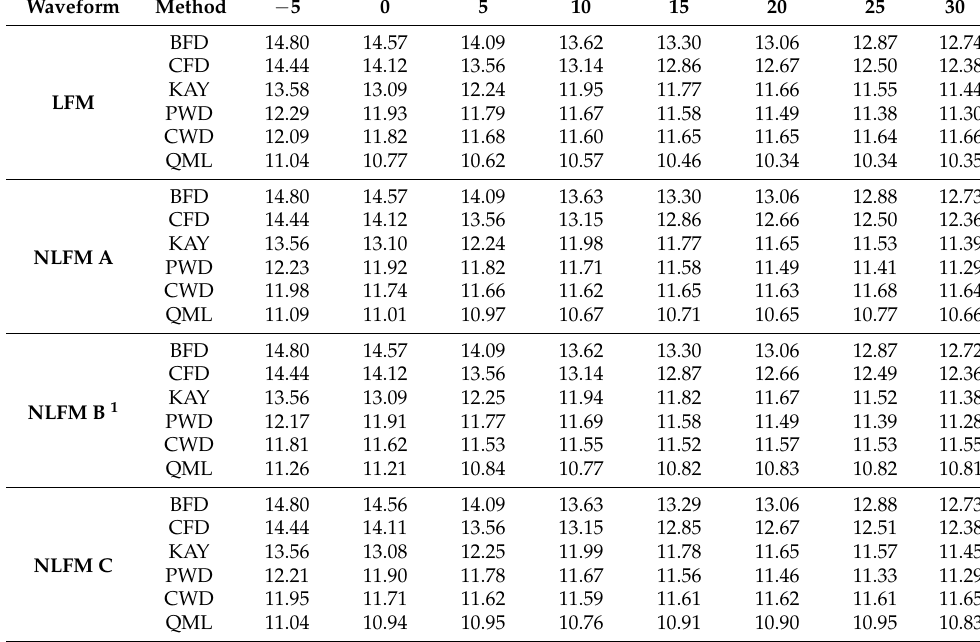
Table A1. Comparison of IF estimators’ accuracy, for various linear and nonlinear frequency mod- ulated waveforms, in a function of SNR. It is worth noting that the accuracy of finite difference methods is actually independent of the signal